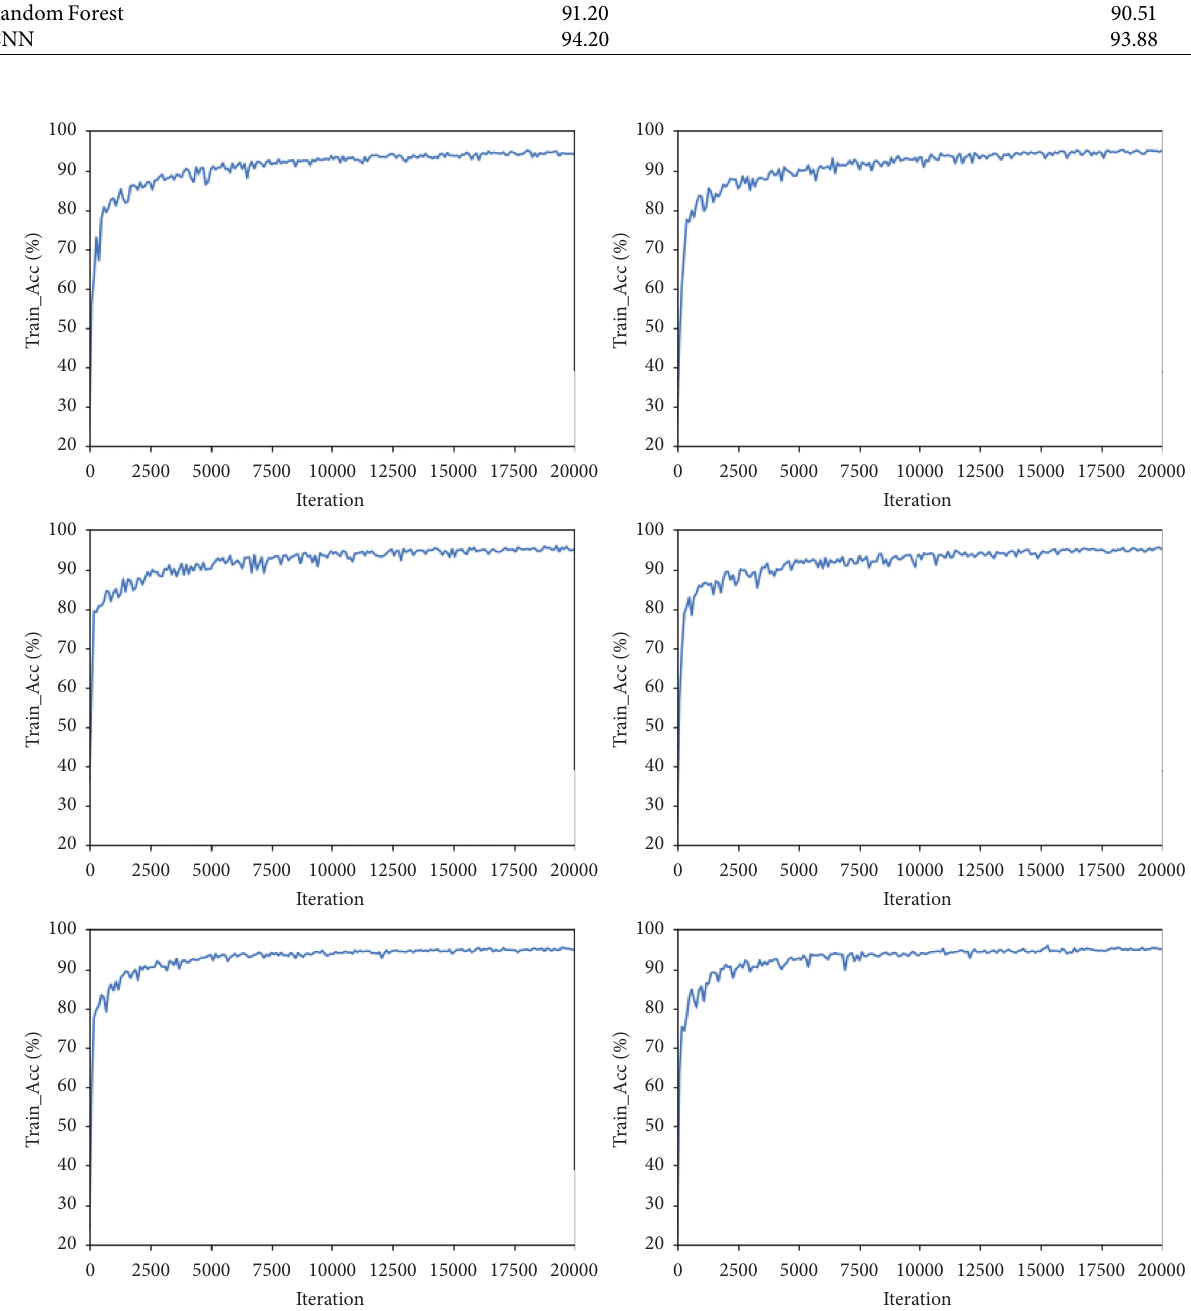
Figure 4: Training process of each base classifier (left to right and top to bottom